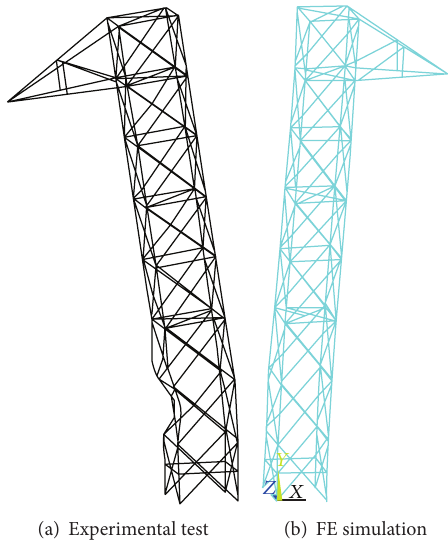
Figure 10: Deformed shapes from the bending test.